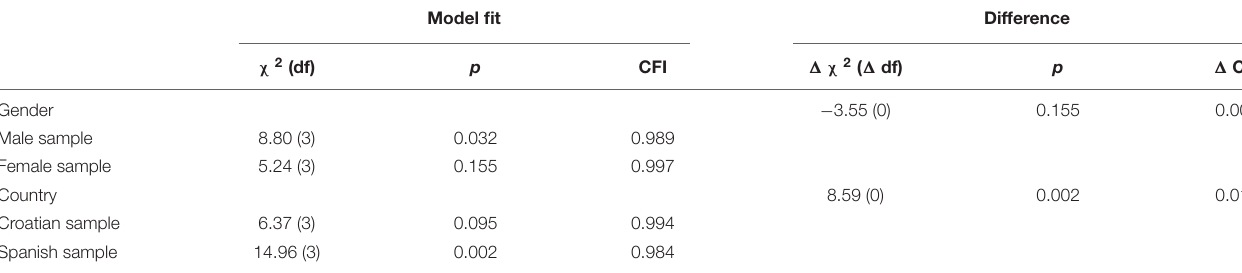
TABLE 2 | Measurement invariance by gender and country in the confirmatory factor analysis of PYD